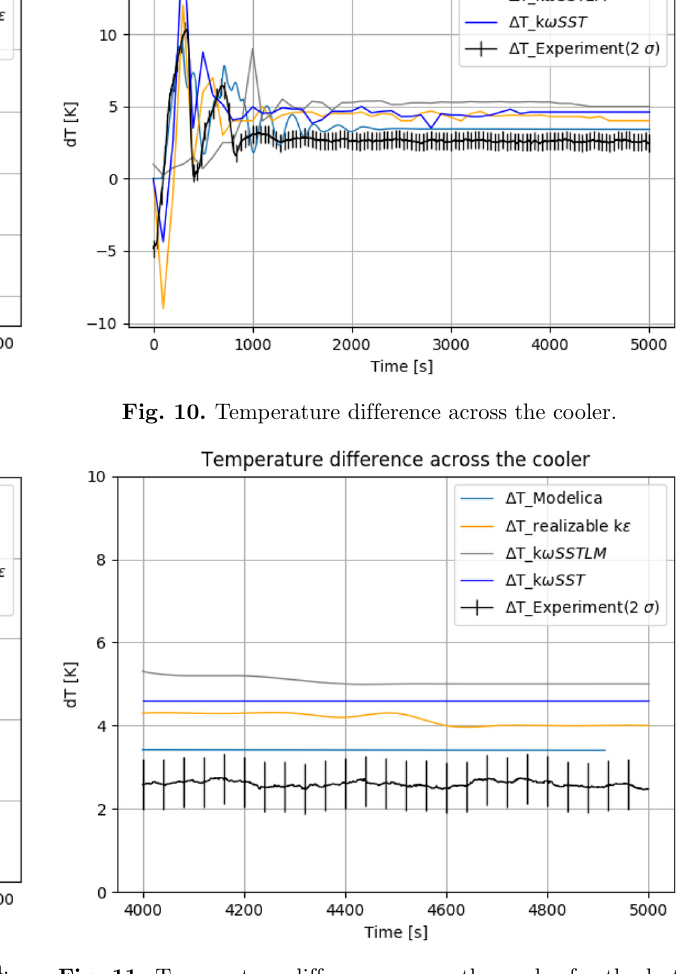
Fig. 11. Temperature difference across the cooler for the last 1000 s. Table 9. The average stabilized temperature